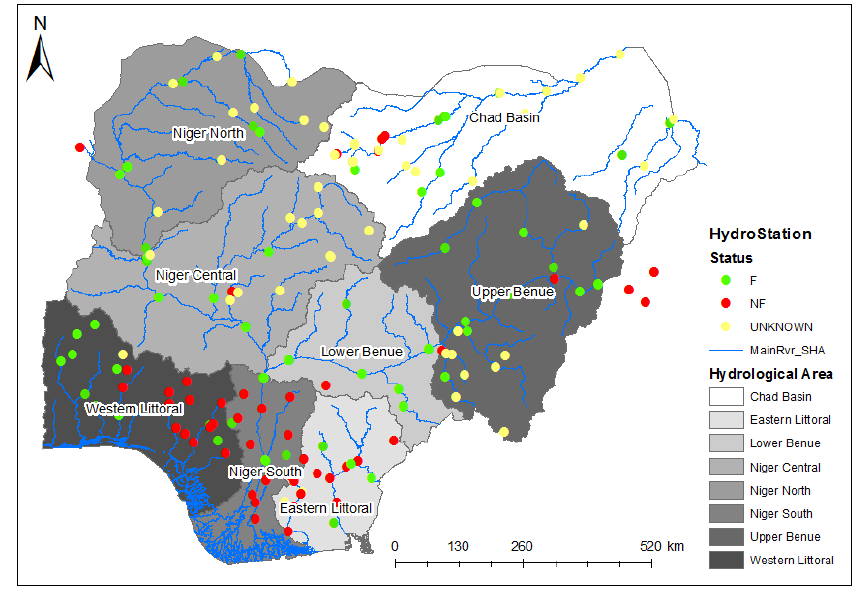
Figure 5. Status of some hydrological gauging stations in Nigeria (F = Functional, NF = Non ‐ Figure 5. Functional, Unknown).